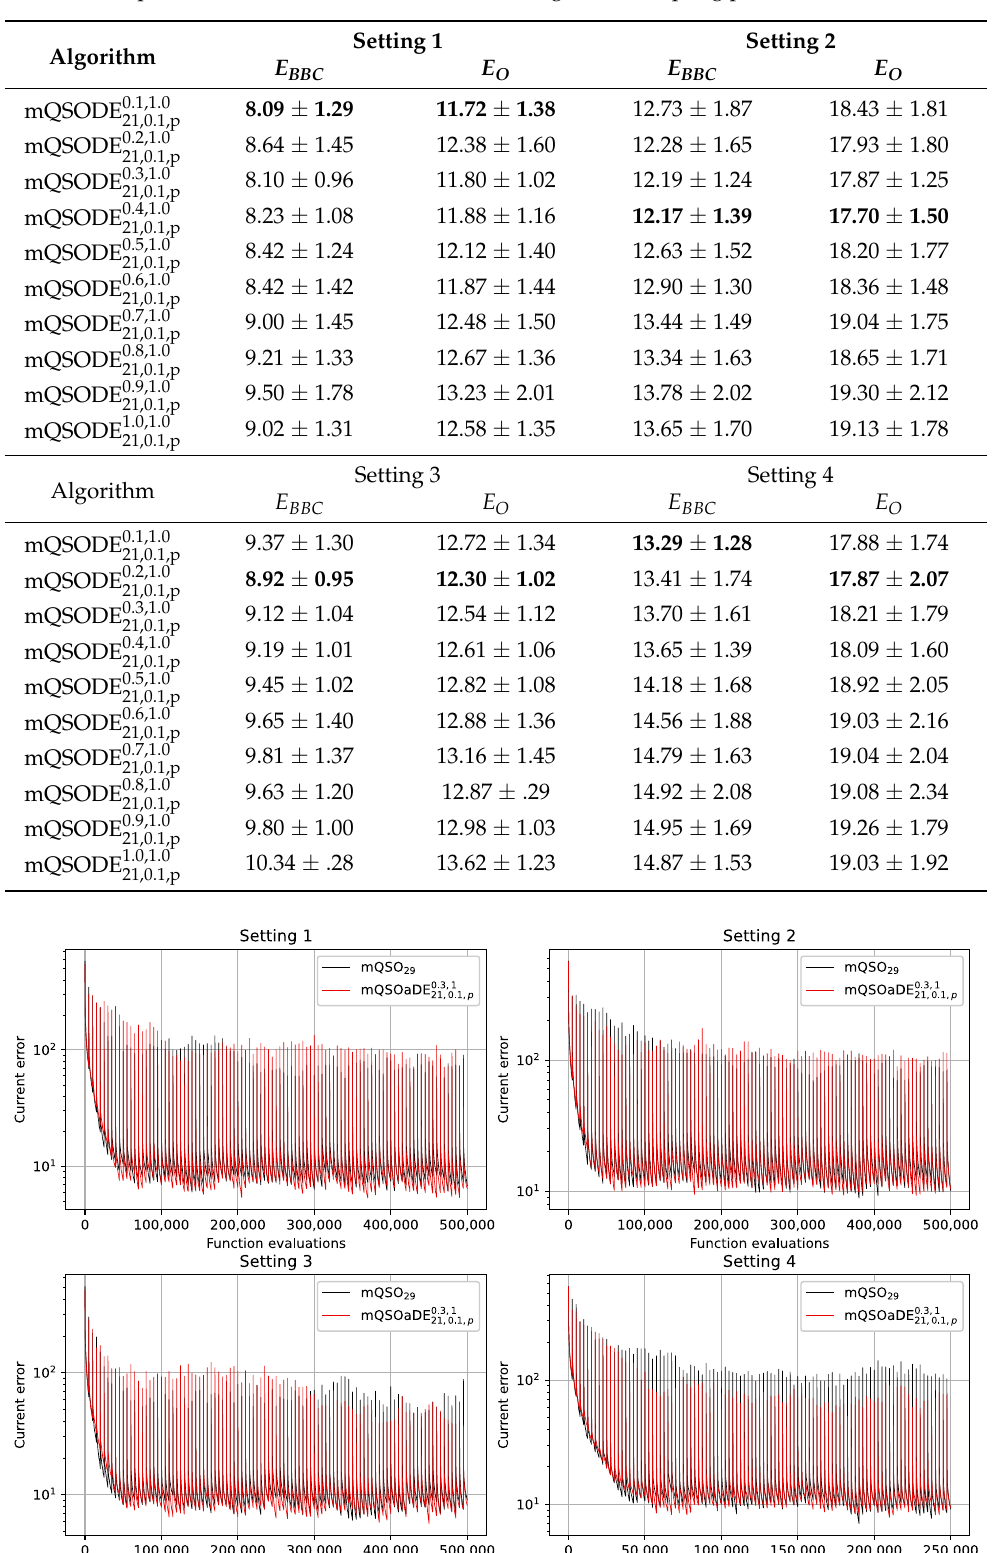
Table 7. Comparison of mQSODE, with different scaling factor sampling parameters.